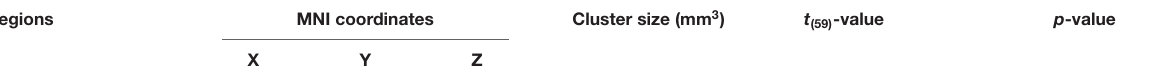
TABLE 3 | Brain regions with significant local degree differences between stroke patients and HCs. Brain regions